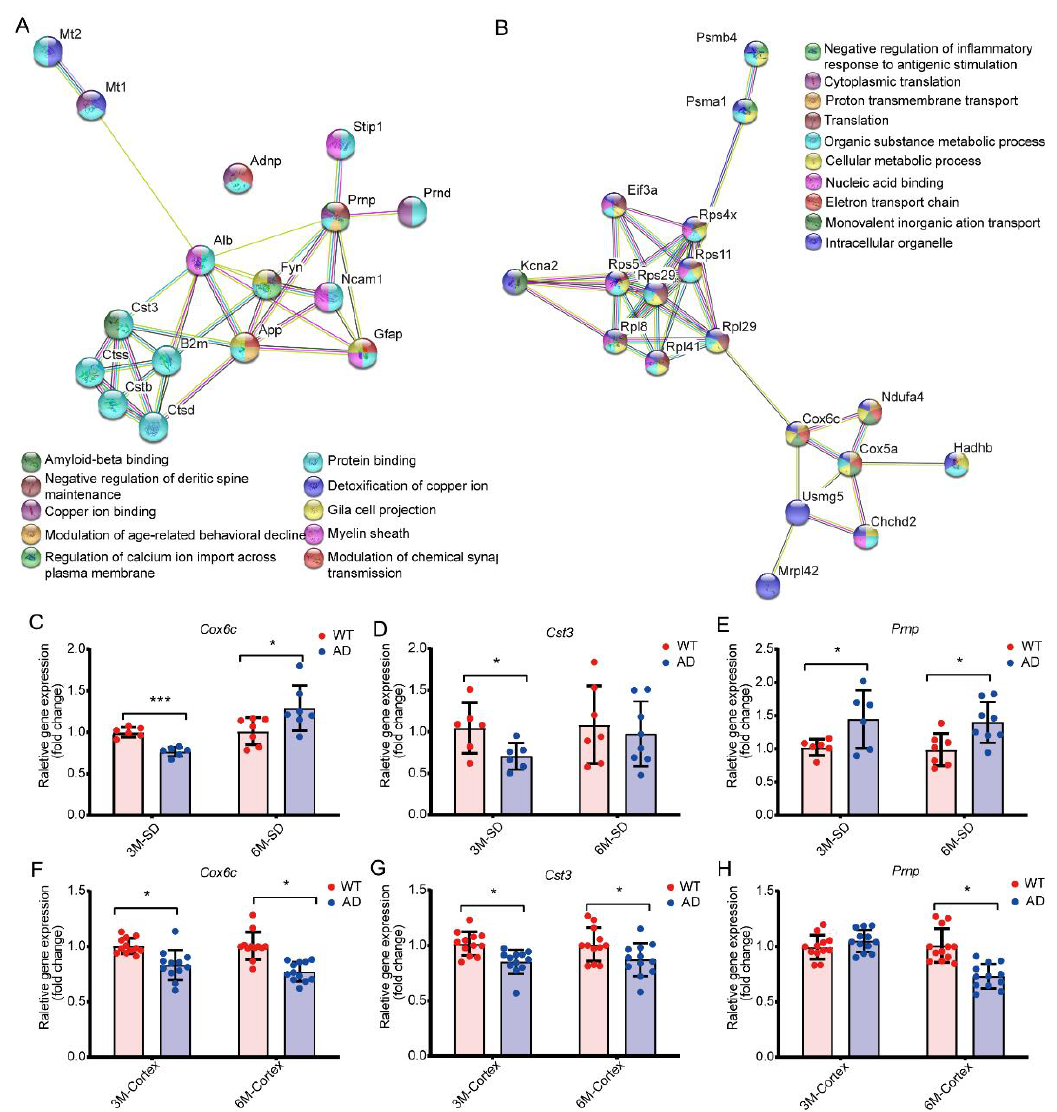
Figure 4. Protein – protein interaction network visualization and synaptically localized gene selec- Figure 4. Protein–protein interaction network visualization and synaptically localized gene tion. ( A , B ) Identical genes from Figure 3B with significant changes ( p < 0.05, fold-change ≥ 1.2 or